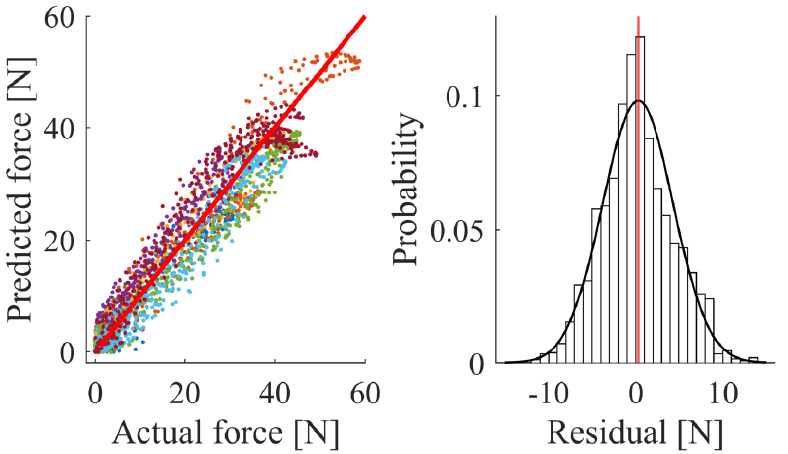
Figure 11. The calibration of the sensors results in a predicted force that matches the actual force with R 2 − value of 90.97% across all of the participants. The standard deviation of the residuals between the predicted force and the actual force is 4.1 N.